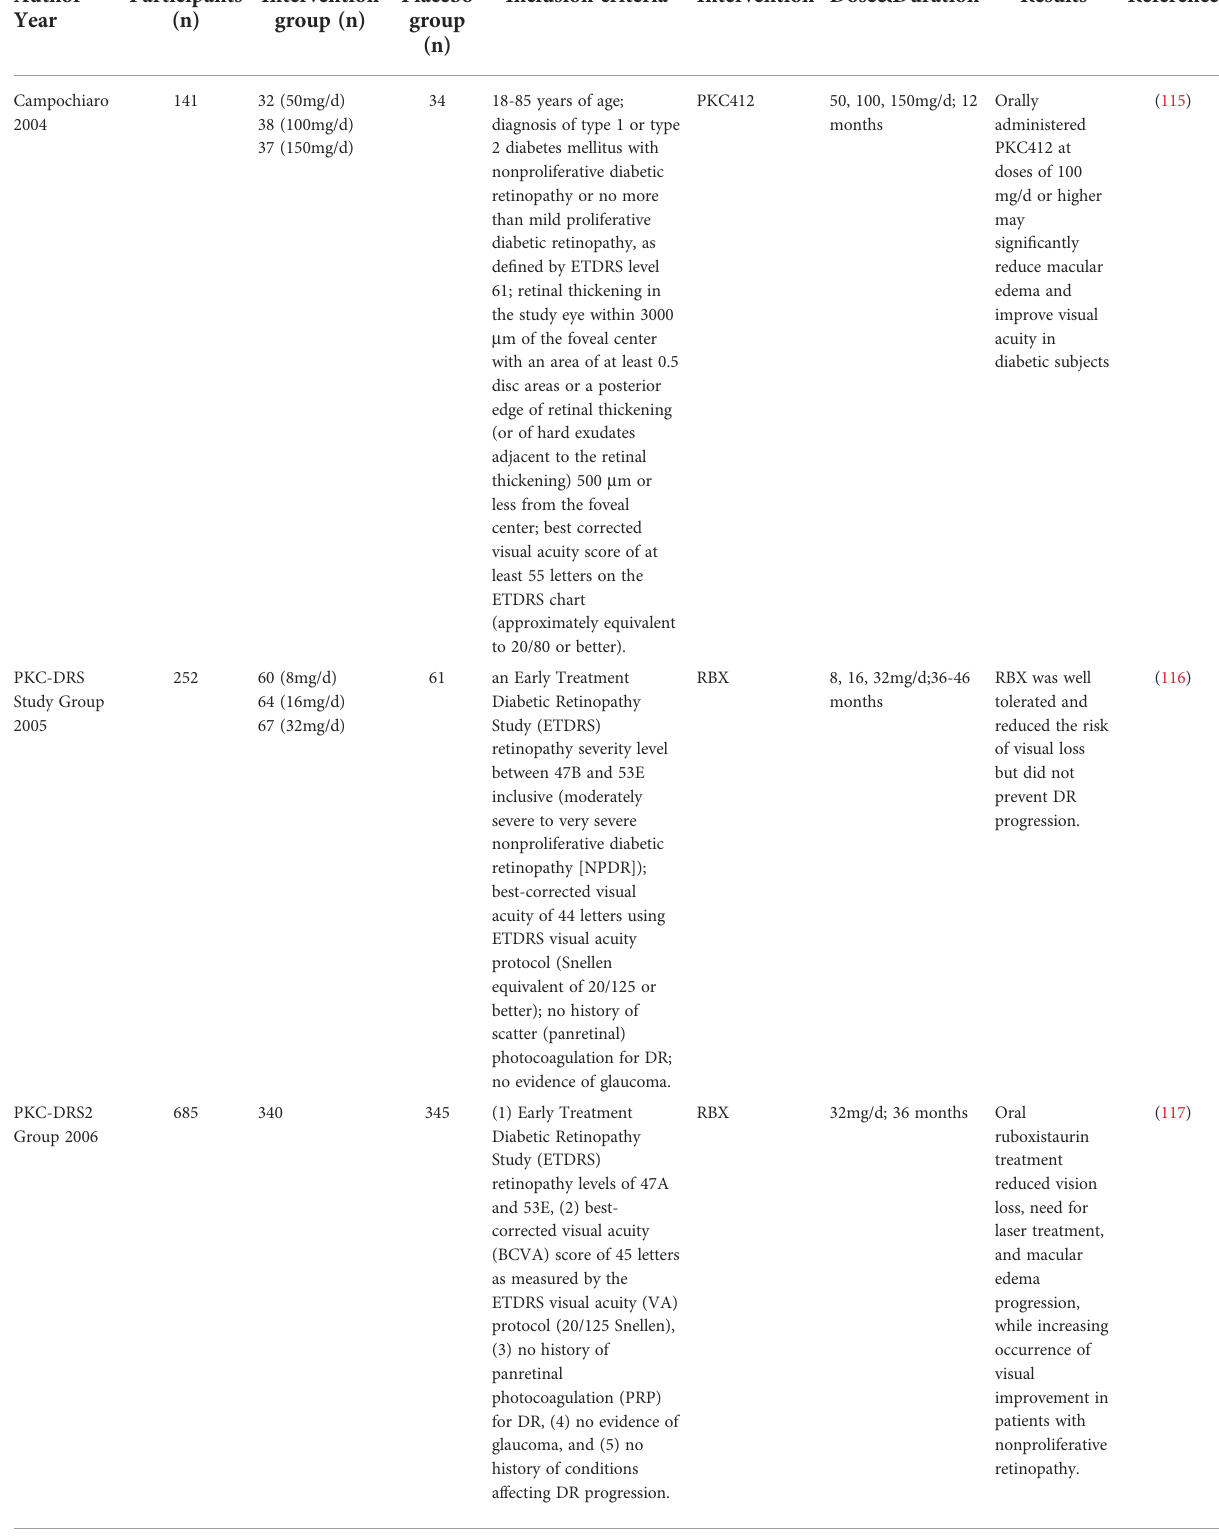
TABLE 1 Clinical trials of PKC inhibitors on diabetic microvascular